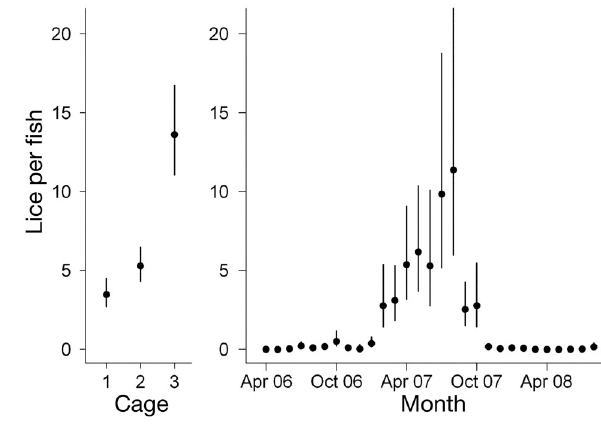
Fig. 4. Cage and month effects on sea lice (all stages) counts from the sentinel fish. Dots are the estimated effects, and vertical lines are pointwise 95% confidence limits. For inter- pretability, cage effects are standardised to June 2007, fish length of 235 mm (median length of the sentinel fish), and water volume of 10 5 m 3 (close to the median volume), while the month effects are standardised to Cage 2, fish length of 235 mm, and volume of 10 5 m